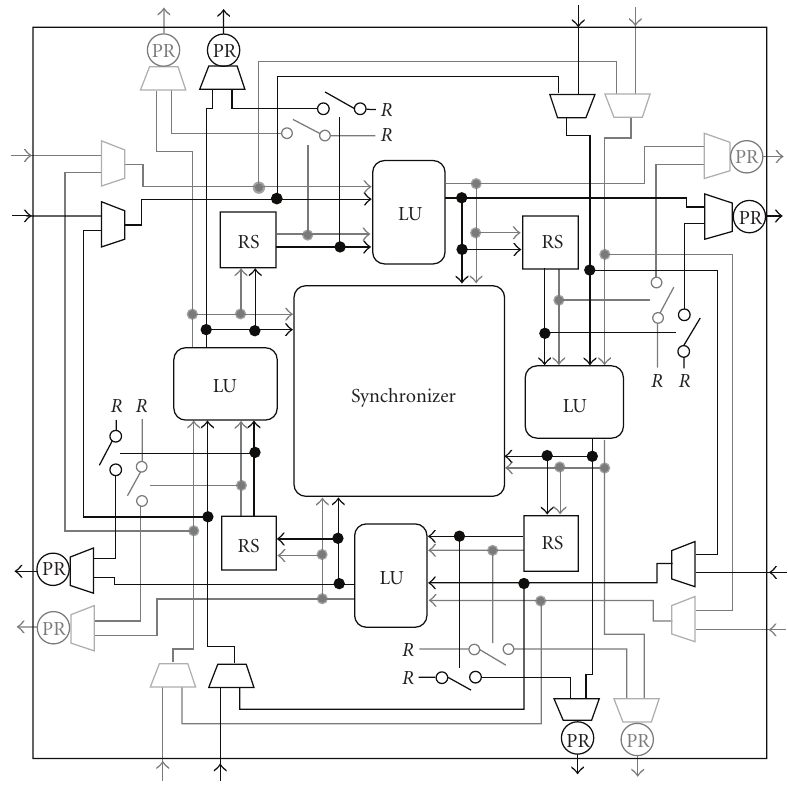
Figure 8: Composite diagram of the PQ-cell including a pulse regenerator (PR) at each output.